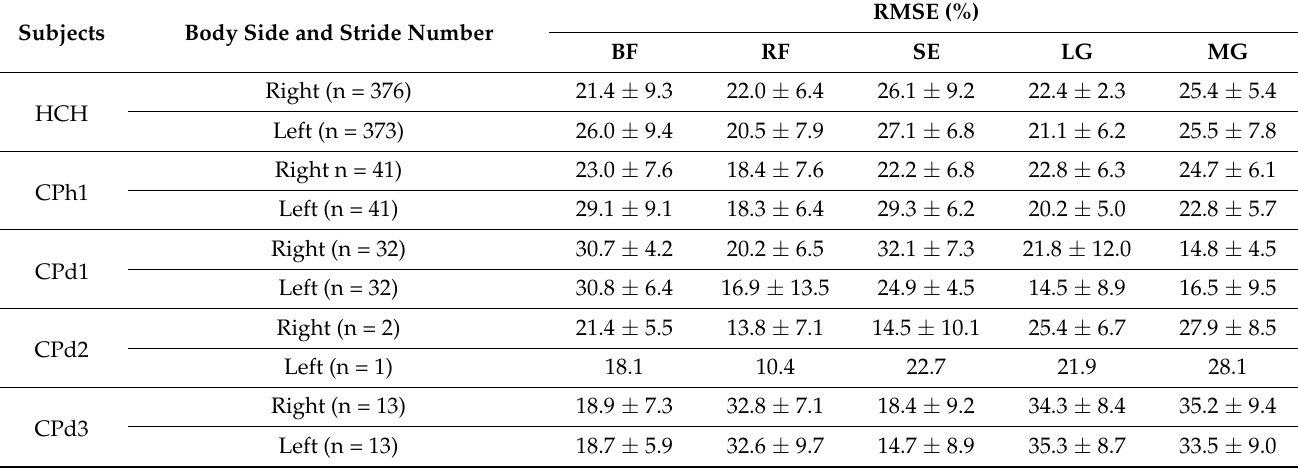
Table 3. RMSEs between muscle